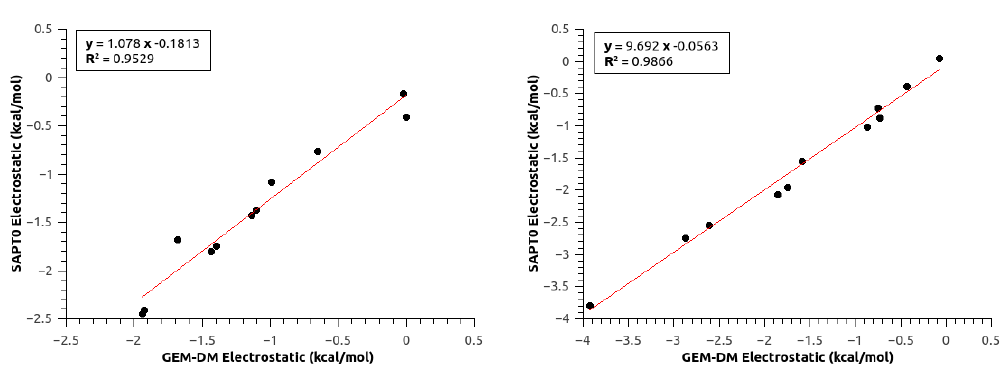
Figure 1. Intermolecular Coulomb interaction for the set of randomly oriented aniline/water ( left ) and [(Boc) 2 O]/water ( right )